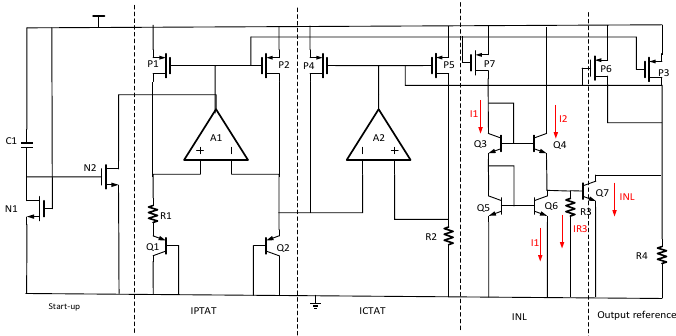
Figure 4. Proposed the second bandgap reference.